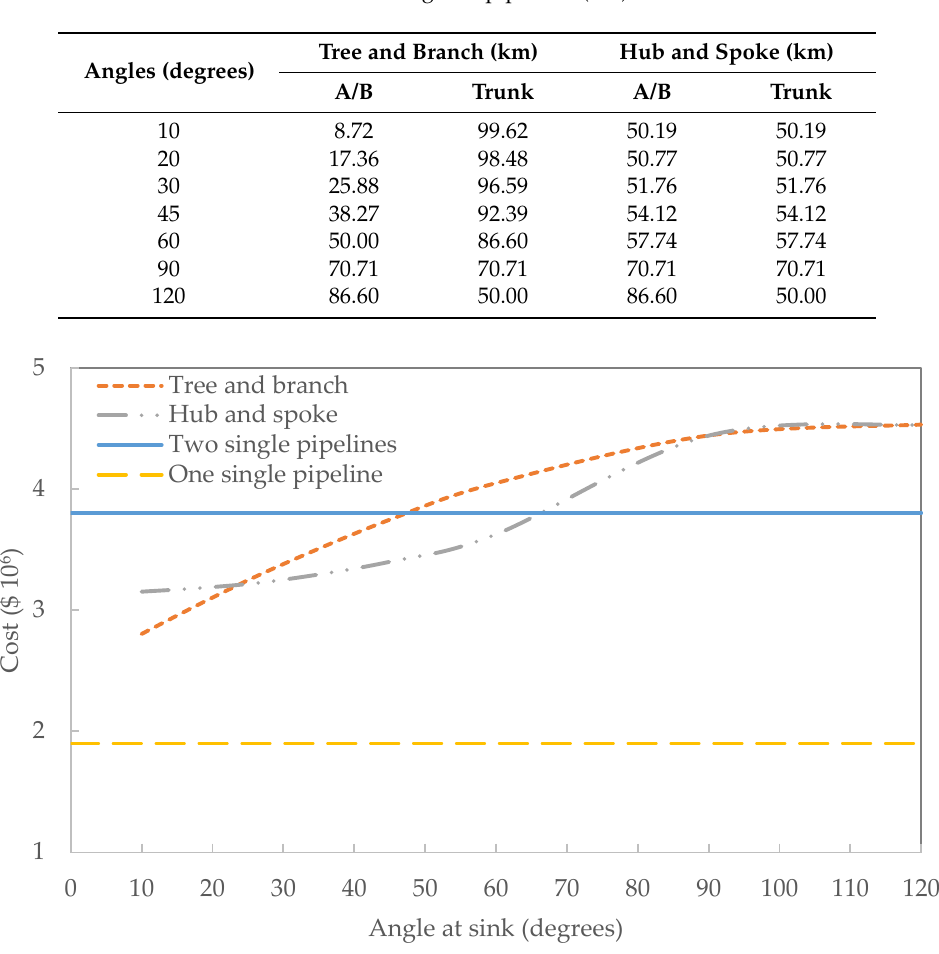
Figure 2. Capital cost profile of different pipeline scenarios.